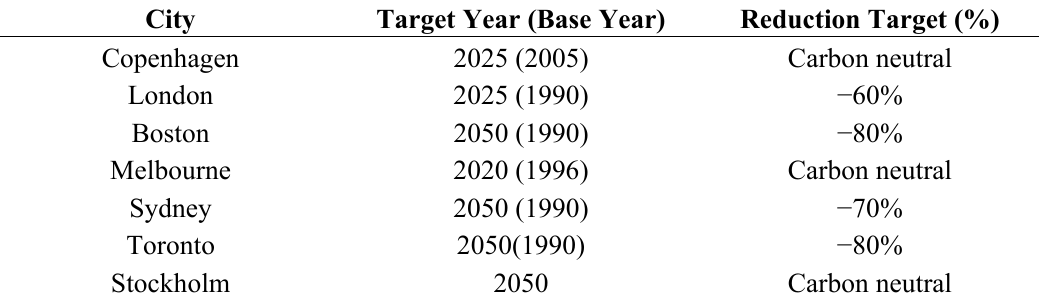
Table 1. Long-term carbon reduction targets for cities of the world